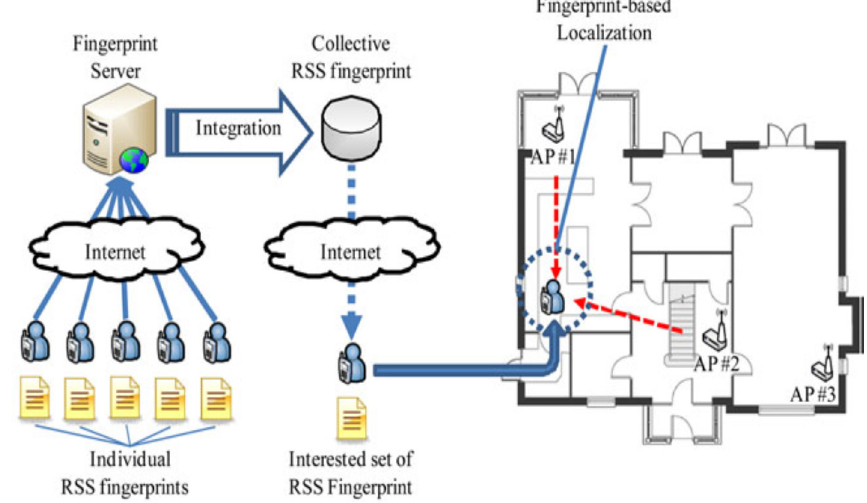
Figure 10. Fingerprint-based localization [45].